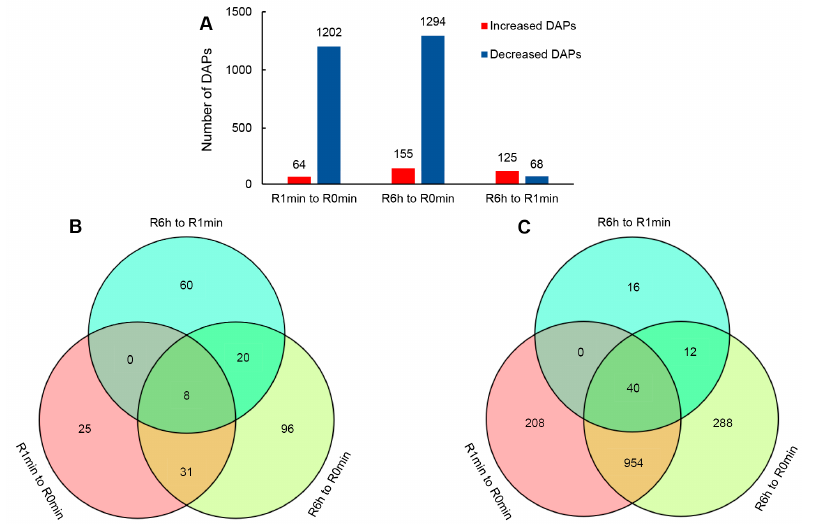
Figure 3. Summary of differentially accumulating proteins in R. canescens during the early stages of rehydration: ( A ) number of proteins whose abundance changed during at the first 1 min and 6 h of rehydration; ( B ) Venn diagram showing the extent of overlap between proteins that quickly accumulate in response to rehydration at various time points; ( C ) Venn diagram showing the extent of overlap between proteins whose abundance quickly decreases in response to rehydration at various time points. R0min, desiccated R. canescens ; R1min, R6h: R. canescens rehydrated for 1 min or 6 h, respectively.